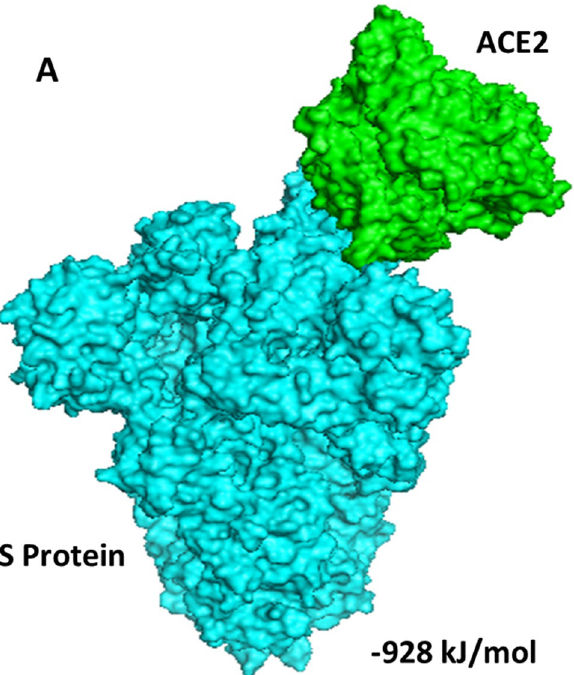
Figure 2. Docked model depicting interaction of S Protein with ACE2 receptor in the absence of